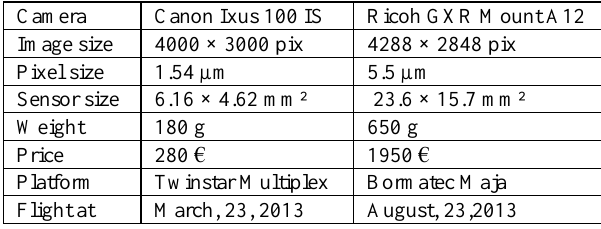
Table 1: Evaluated camera configurations flown at